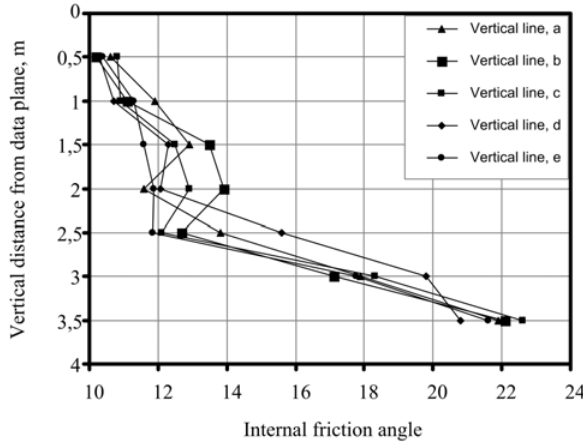
Fig. 8. Graph of h ϕ − relationship according to field